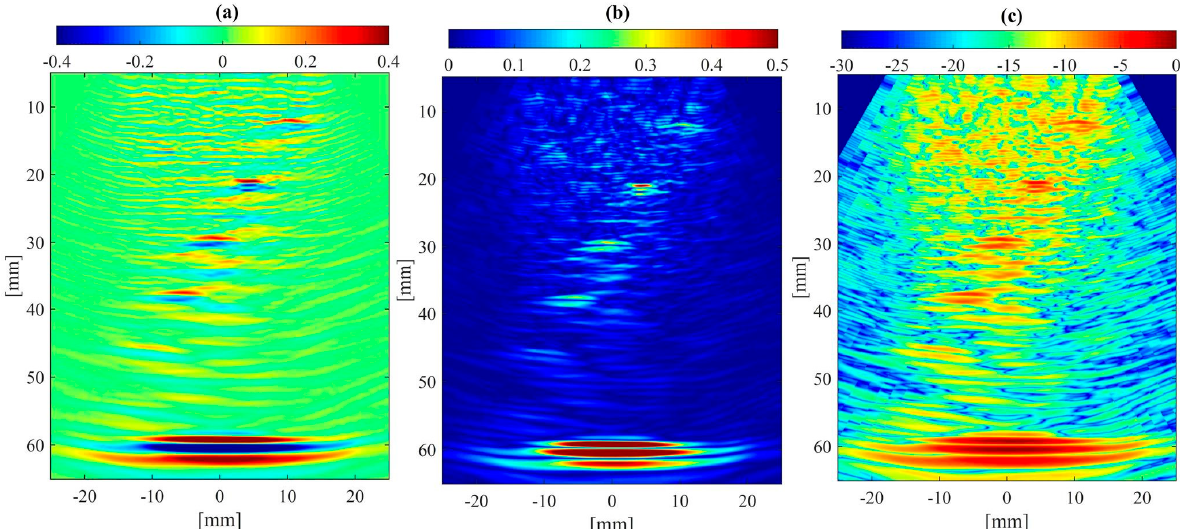
Figure 10. TFM image of the sample obtained using pulse-compression and chirp excitation signals with a central frequency of 2.25 MHz. The central frequency of the array transducer was 2.25 MHz as well. The image is reconstructed considering ( a ) the full-wave amplitude, ( b ) energy, and ( c ) the energy shown in the dB scale of the echo signals.